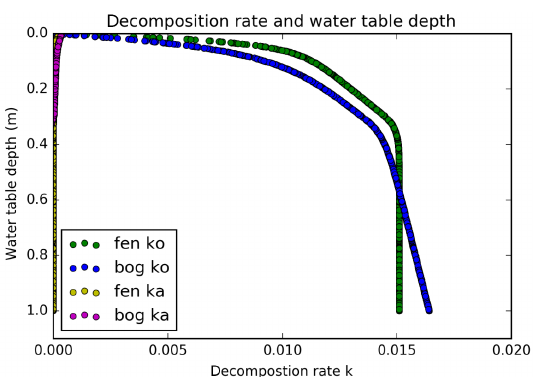
Figure 2. Variation of respiration rate coefficients k o and k a with water table depth.